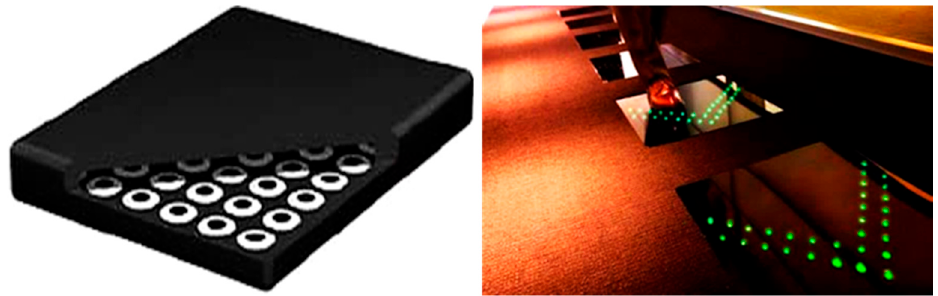
Figure 38. SoundPower ® ’s tiles [96].